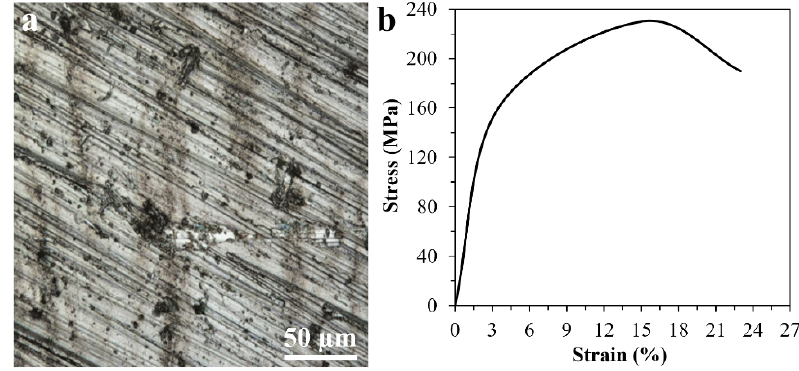
Figure 2. LSM image ( a ) and compressive stress-strain curve ( b ) of our AZ91 Mg alloy.